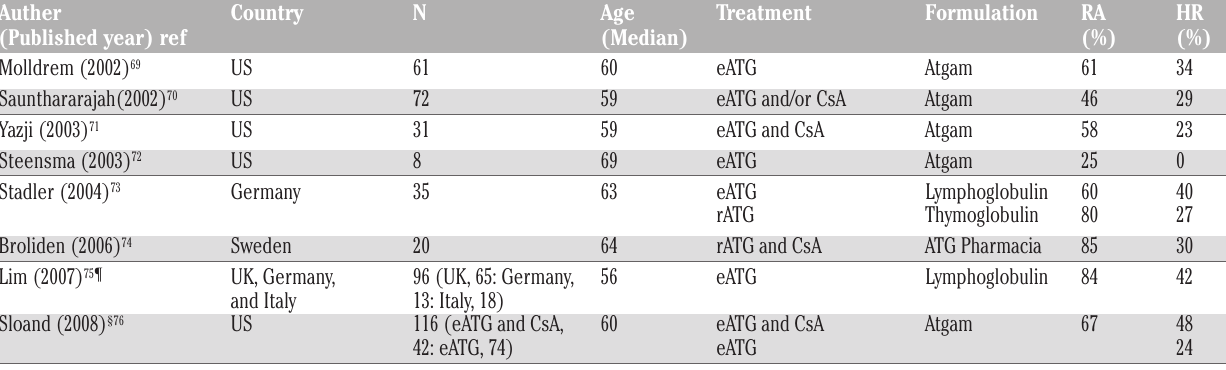
Table 3. Clinical trials of ATG based regimen.